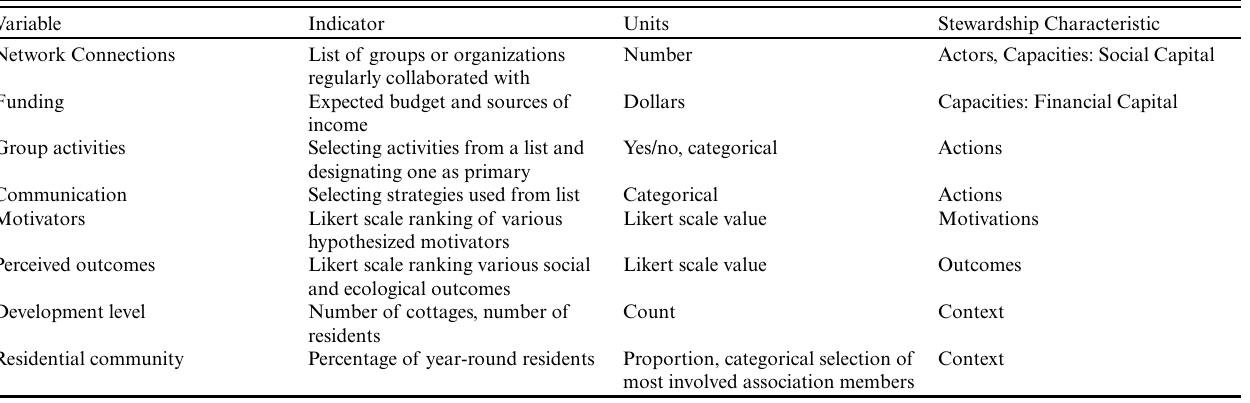
Table 1 . The variables of interest about bright spots, indicator used in a survey sent to all 20 lake associations in the Rideau Valley, Ontario, and units of measurement, plus stewardship characteristics drawn from Bennett et al. (2018)’s conceptual framework of local environmental stewardship.